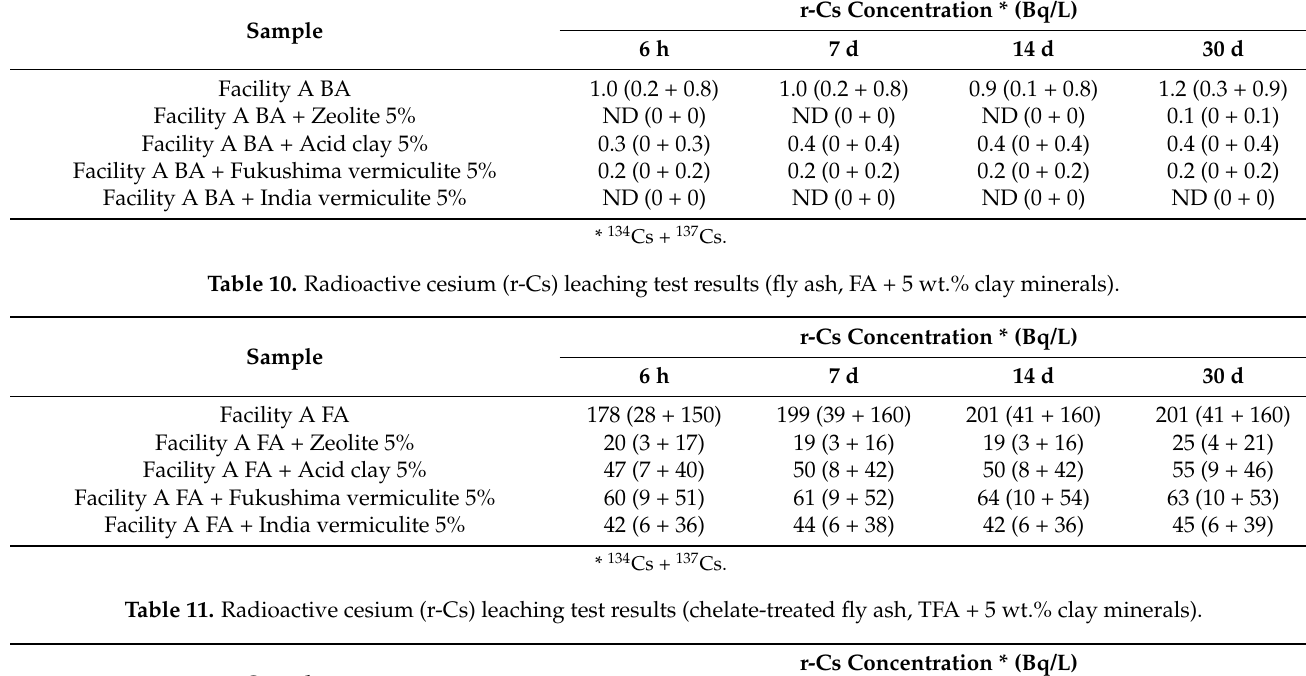
Table 9. Radioactive cesium (r-Cs) leaching test results (bottom ash, BA + 5 wt.% clay minerals). Sample